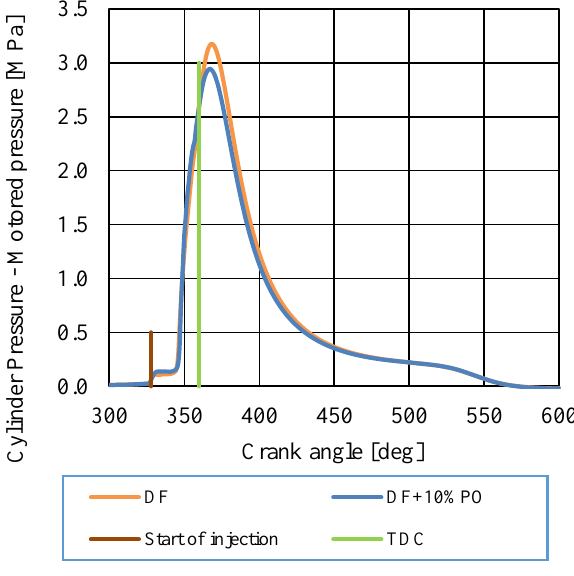
Fig. 10. Combustion pressure increase The injector characteristics were determined for the ref- erence fuel (DF) and for the tested mixture: DF+10%PO. Fig. 8. Unrepeatability of the engine work for reference fuel and for The results are shown in Fig. 11. research fuel